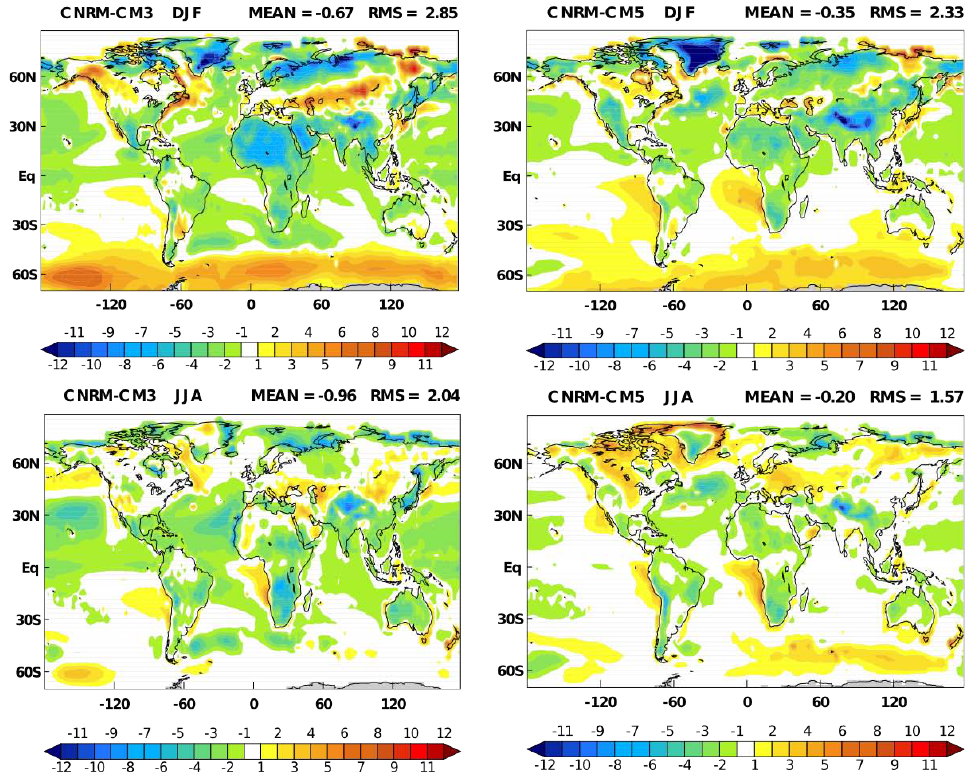
Fig. 10. Near-surface temperature over continents and sea surface temperature over oceans (K) averaged over 1970–1999: (left) CNRM-CM3 simulations minus 1970–1999 CRU2.1 over continents and CNRM-CM3 simulations minus 1970–1999 HadiSST over oceans, (top) winter, (bottom) summer, and (right) same for the CNRM-CM5.1 runs. The CNRM-CM5 runs are averaged over an ensemble of 10 members.